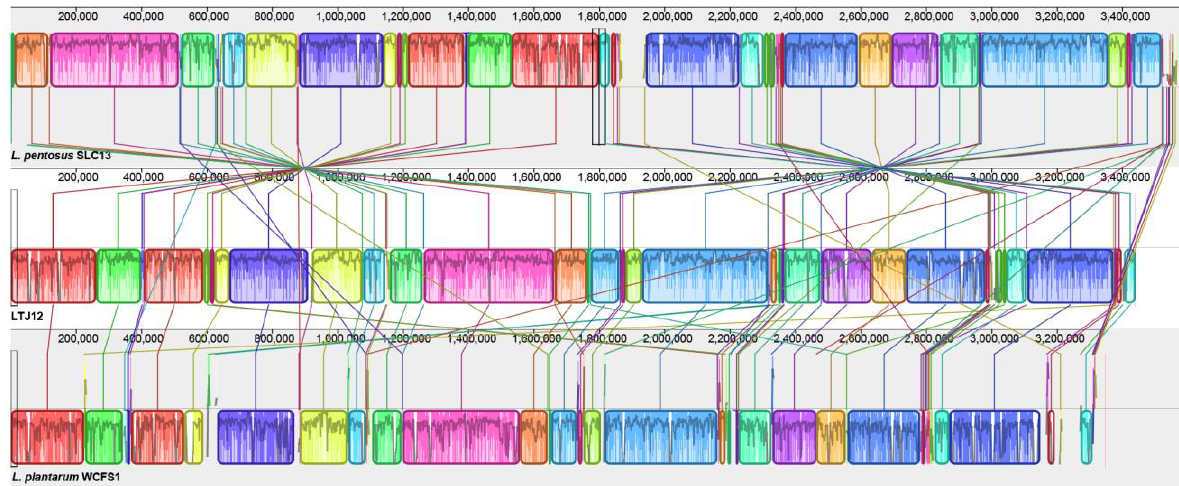
Figure 9. Mauve Alignment of the strain LTJ12, L. pentosus SLC13 and L. plantarum WCFS1.